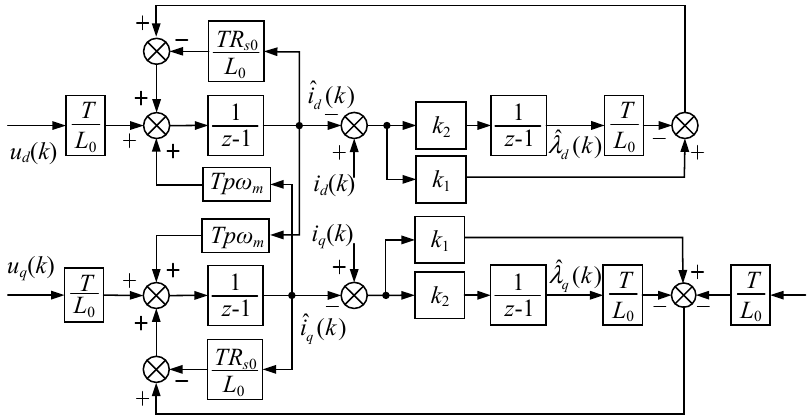
Figure 5. Block diagram of the robust observer-based FCS-MPCC strategy.